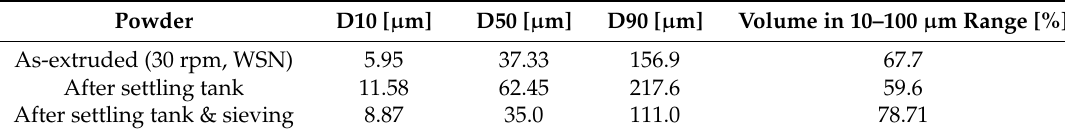
Table 3. Particle size distributions of the powder after different classification process